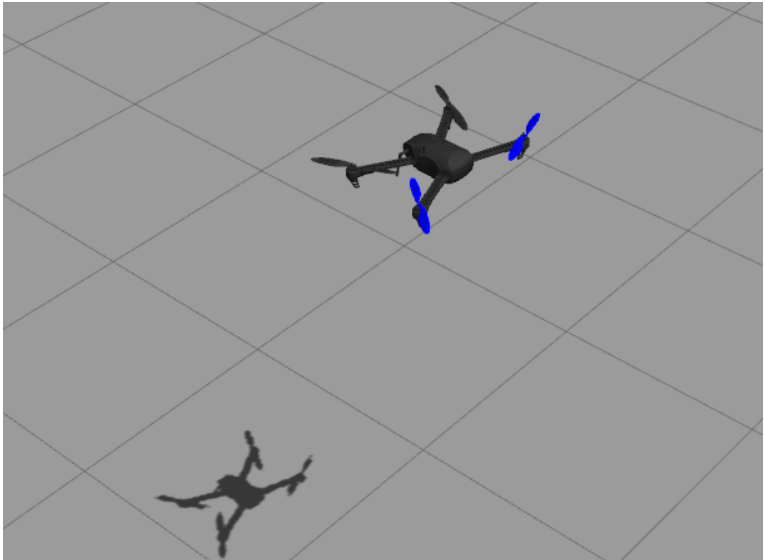
Figure 5. A snapshot of the Iris quadrotor model flying in the Gazebo